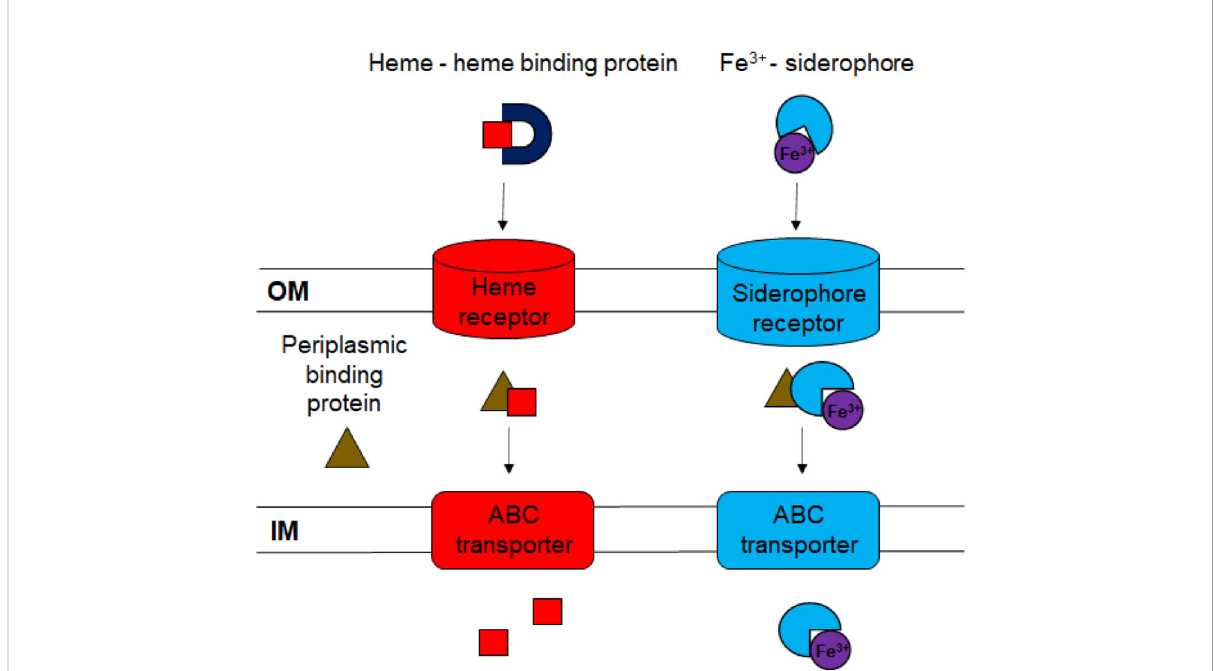
FIGURE 1 Diagram of ferric iron uptake systems. Ferric iron bound to siderophores or to heme is transported across the outer membrane (OM) using speci fi c outer membrane receptors. The dark blue “ U ” represents the heme-binding protein HmuY. Periplasmic binding proteins deliver the ferri-siderophores and heme to ABC transporters in the inner membrane (IM), where they are transported to the